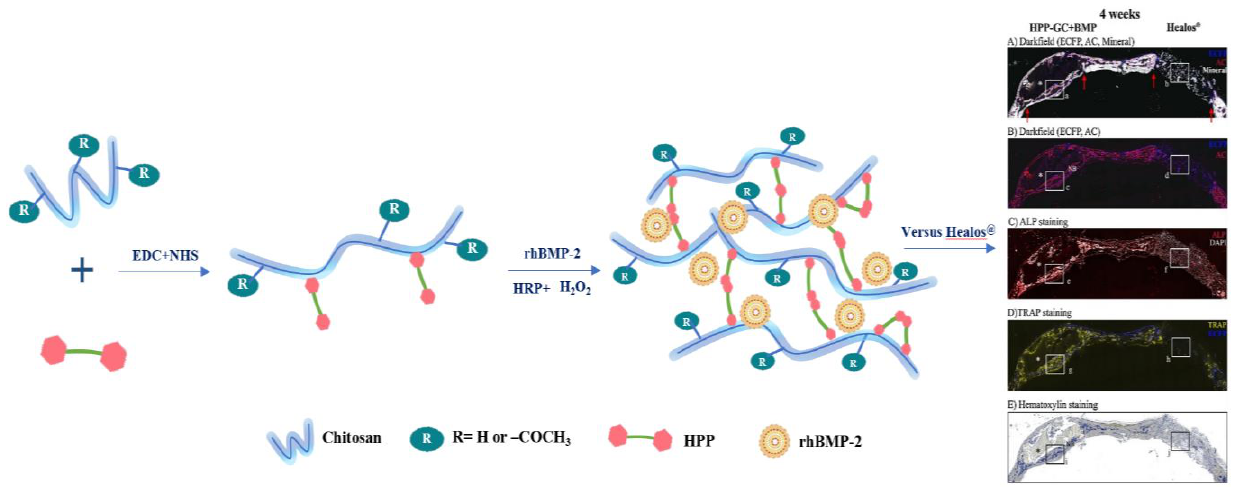
Figure 6. Scheme of developing and characterizing the microparticles of rhBMP-2 loaded HPP-GC